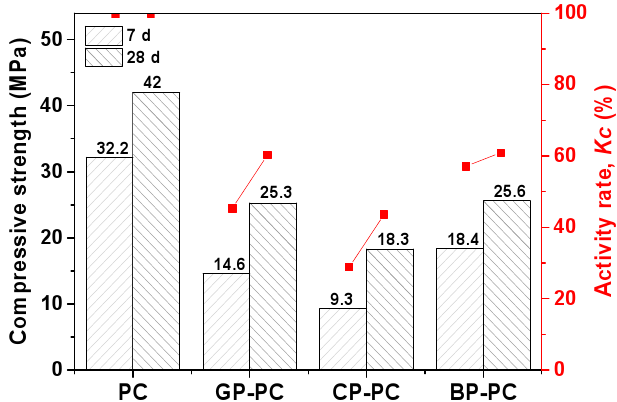
Figure 4. The activity rate ( Kc ) of glass powder as supplementary cementitious materials as repented by compressive strength change.